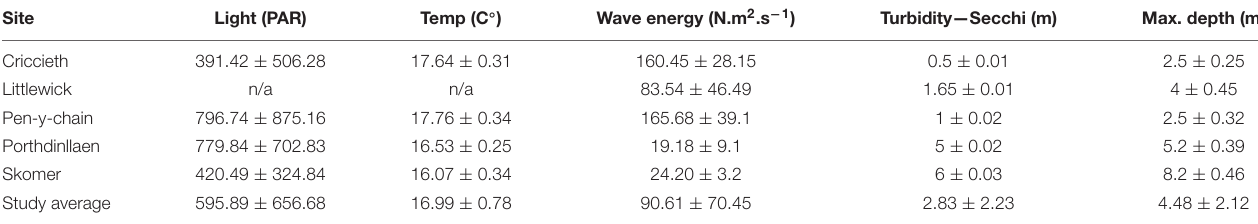
TABLE 3 | Abiotic and environmental data collected for each site collected in August-September 2016, averages ± standard deviation.